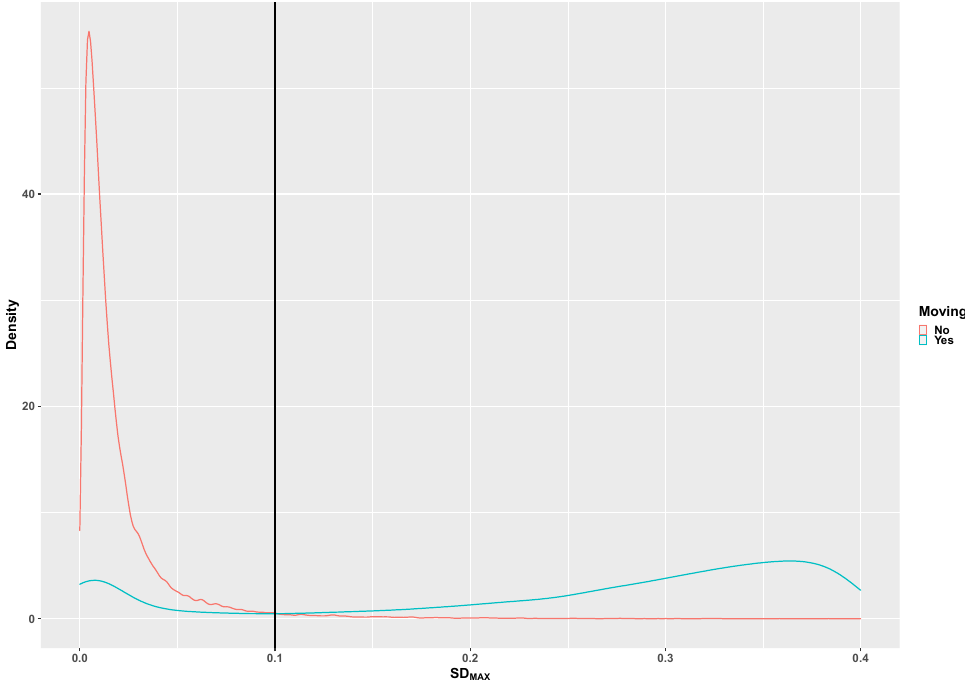
Figure 2. The pooled distribution of the SD MAX signal for moving (green curve) and non-moving (red curve) activities. The vertical line represents the original adult 0.1 g SD MAX threshold (Skotte et al. 2014).